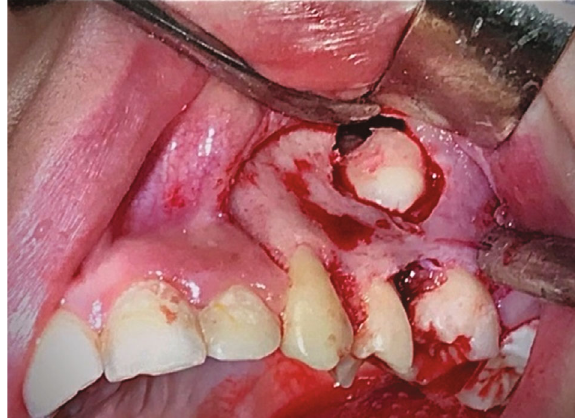
Figure 8: Localization of ectopic tooth.